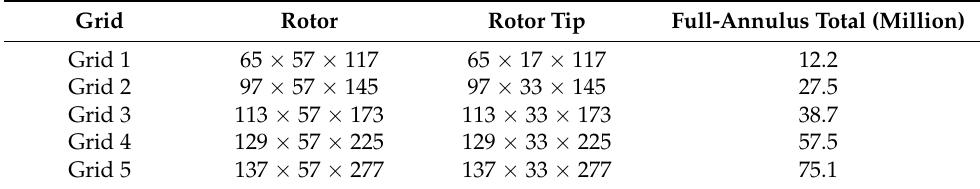
Table 3. Detail information of Table 2. Boundary conditions.